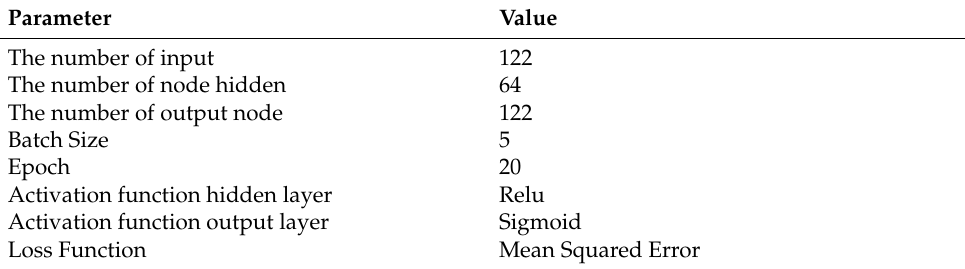
Table 6. The parameters for building the Autoencoder model on